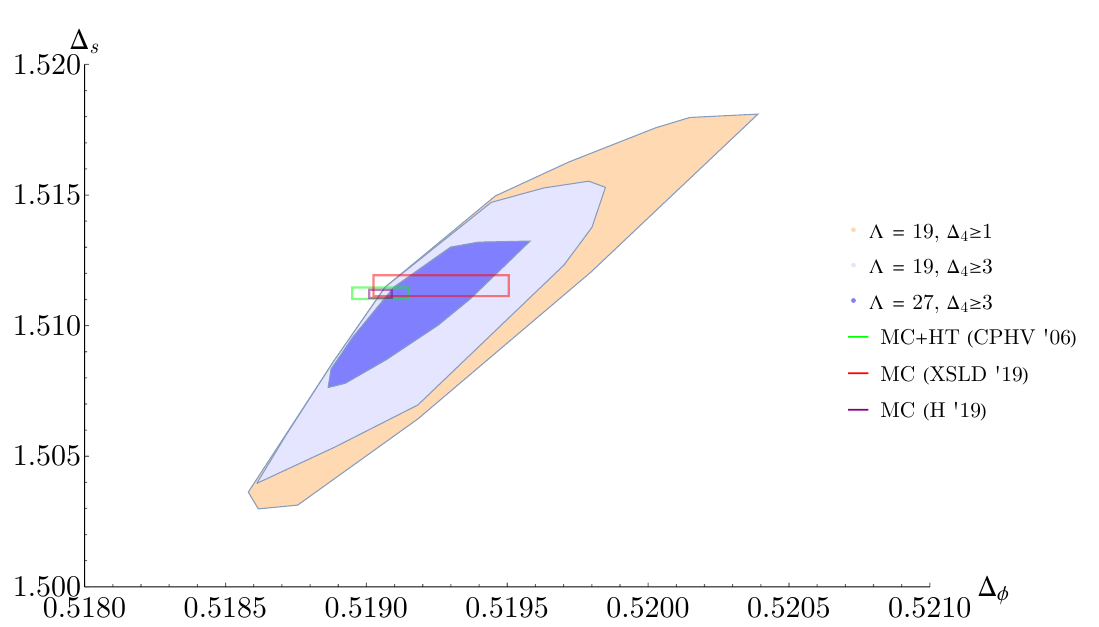
Figure 8 . Bounds on the scaling dimensions (cid:1) (cid:30) ; (cid:1) s computed without the cutting surface algo- rithm described in section 3.3. The light orange region shows the bound computed with (cid:3) = 19 and a conservative gap assumption in the charge-4 scalar sector (cid:1) 4 (cid:21) 1. The light blue region shows the bound at (cid:3) = 19 with a stronger gap assumption (cid:1) 4 (cid:21) 3. The dark blue region shows the bound at (cid:3) = 27 with the stronger gap assumption. The results are compared with the recent Monte